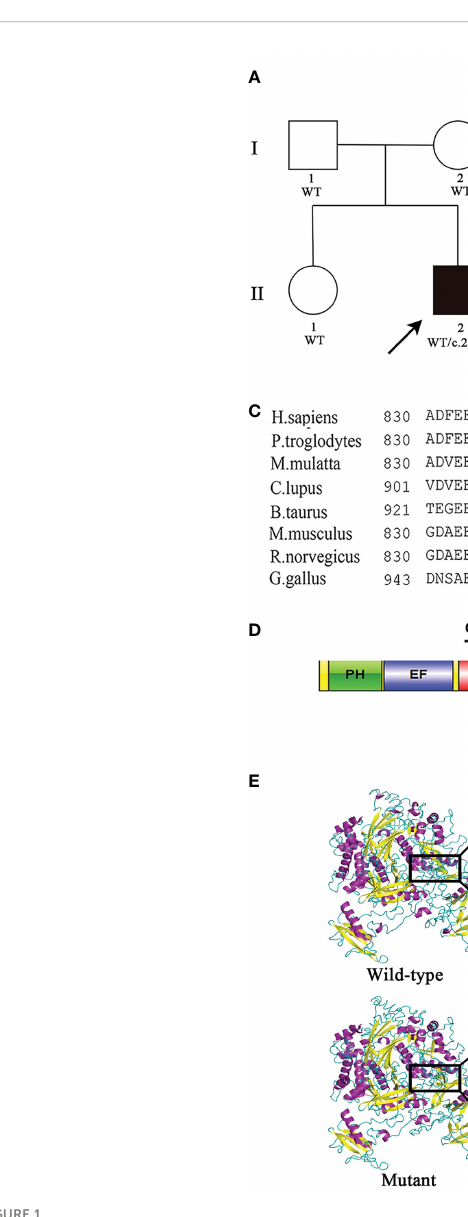
FIGURE 1 A novel de novo heterozygous mutation is identi fi ed in PLCG2 . (A) Pedigree of the affected family. Circles, females; squares, males; fi lled symbol, affected subject; open symbols, unaffected family members. The proband is indicated by an arrow. (B) DNA sequencing of wild-type (WT) and mutant (MUT) PLCG2 . The red arrow indicates the position of the c.2534T>C variant in PLCG2 . (C) The protein alignment shows conservation across eight species. The mutation c.2534T>C occurred at evolutionarily conserved amino acids. (D) Schematic representation of the protein domains of PLC g 2. The mutation identi fi ed in the current report was showed. (E) Protein structure modeling of wild-type and mutated